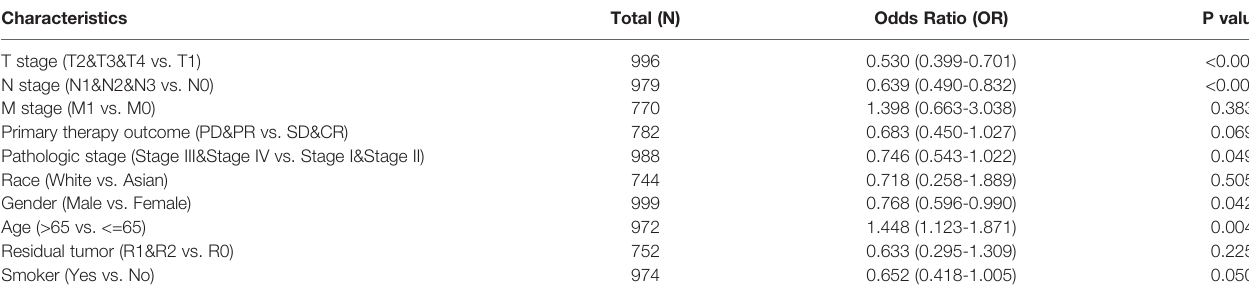
TABLE 2 | miR-30a-5p expression correlated with clinical pathological characteristics (logistic regression). Characteristics T stage (T2&T3&T4 vs. T1)